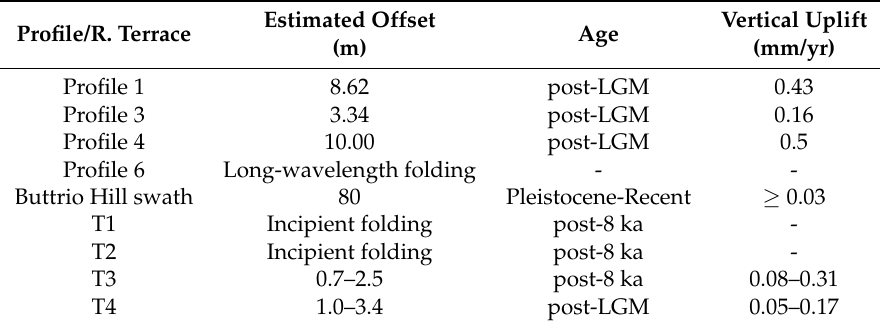
Table 1. Estimated vertical offsets along the Udine-Buttrio Thrust and at the river terraces in the Natisone River valley. The values were obtained by extracting a series of topographic profiles perpendicular to the scarp (see Figures 3, 7, 8 and 9).